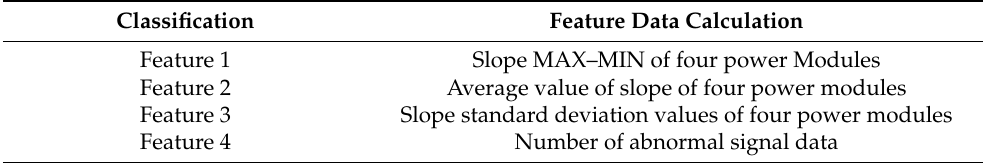
Table 3. Feature data calculation method using analysis section data.